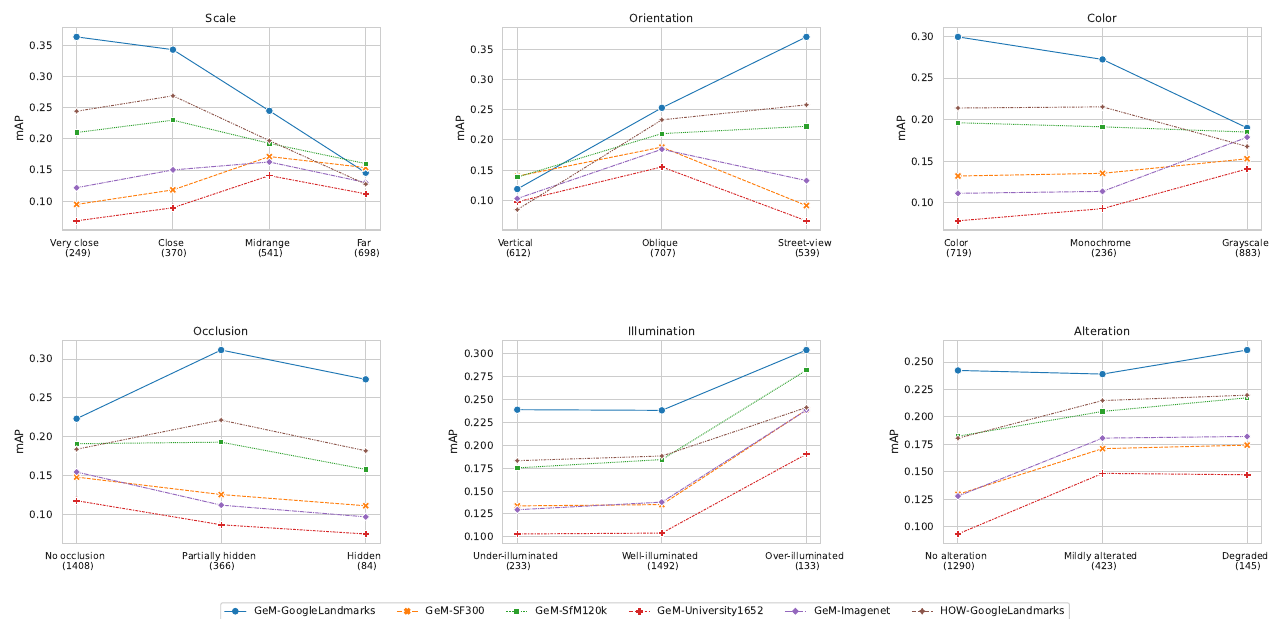
Figure 8. Attribute-specific performance evaluation. The number of corresponding query images is noted in parentheses. Performance should be compared between descriptors on a single value because the varying query set can make absolute performance change independently from attribute